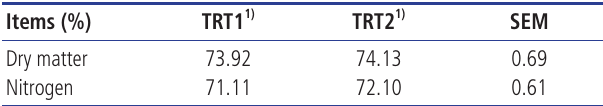
Table 6. Effect of GMO and non-GMO corn-SBM diets on nutrient digestibility of broilers Items (%)